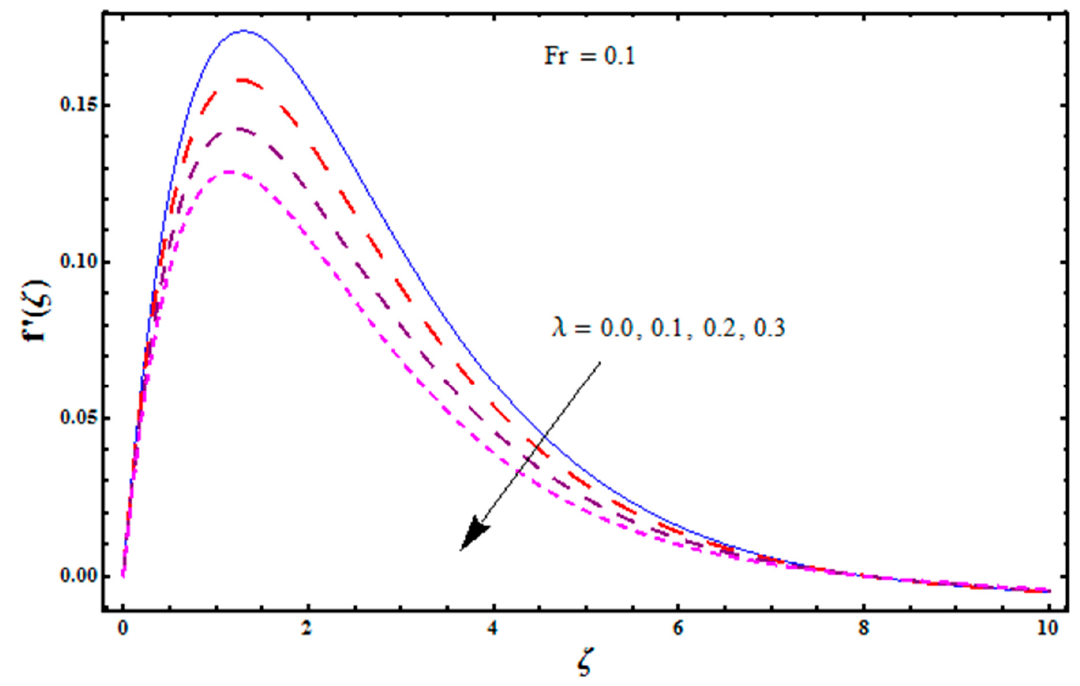
Figure 2. Curves of f (cid:48) ( ζ ) for λ